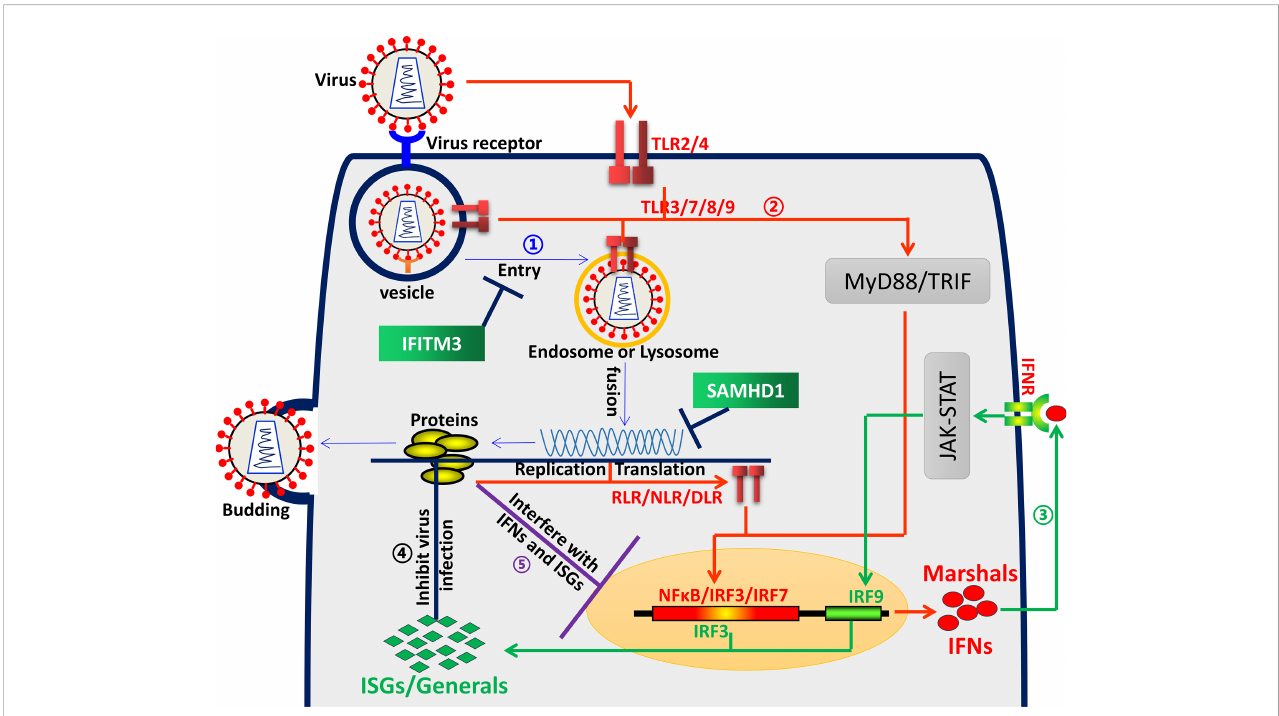
FIGURE 1 Virus and host interaction. ① Blue arrows represent the virus life cycle. A virus fi rst binds to its receptor and entry cells depending on endocytic uptake, then delivers the viral genome into the cytosol and uses a repertoire of cellular processes to complete its replication, assembly and release. ② Red arrows represent the interferon induction process. The host uses an array of pattern recognition receptors (PRRs), such as TLRs, NLRs, etc., to detect unique pathogen-associated molecular patterns (PAMPs), followed by inducing expression of IFNs. ③ Green arrows represent the ISGs induction process. IFNs bind to cell surface receptors (IFNR), triggering a signal transduction cascade, producing hundreds of ISGs. ④ Black lines represent ISGs interfering with virus infection. ISGs delay or inhibit viral infection in different stages, such as entry, viral gene expression and genome ampli fi cation, viral particle assembly and egress, etc., with diverse mechanisms. ⑤ Purple lines represent virus antagonism towards ISGs. Viruses have evolved multiple evasion proteins, targeting IFN signal pathways through various sophisticated mechanisms and escaping IFN-ISG-mediated antiviral